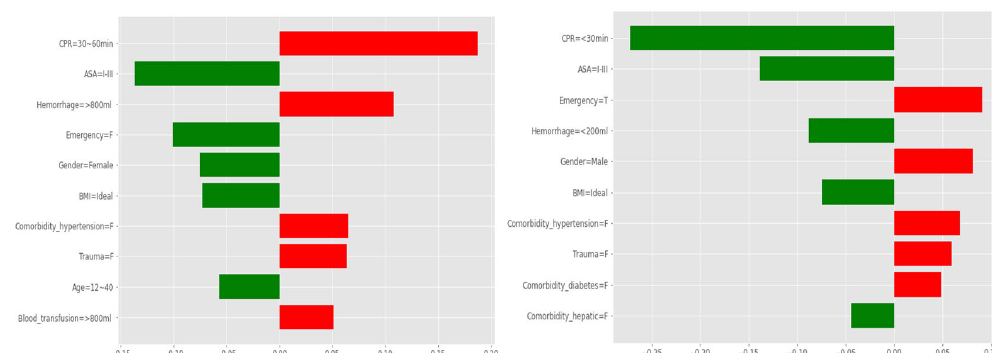
Figure 4. LIME explainer for four typical scenarios. ( a ) True positive, patient died, i.e., a correctly classified non-survivor, ( b ) True negative, patient survived, i.e., a correctly classified survivor, ( c ) False positive, patient survived, i.e., an incorrectly classified survivor (predicted to die), and ( d ) False negative, patient died, i.e., an incorrectly classified non-survivor (predicted to survive). Features with a green bar favored survival, and those with a red bar were predictive of mortality. The x-axis shows how much each feature added to or subtracted from the final probability value for the patient. Each weight can be interpreted in the context of the original probability; if a feature is absent for a patient, it can be numerically added to or subtracted directly from the initial